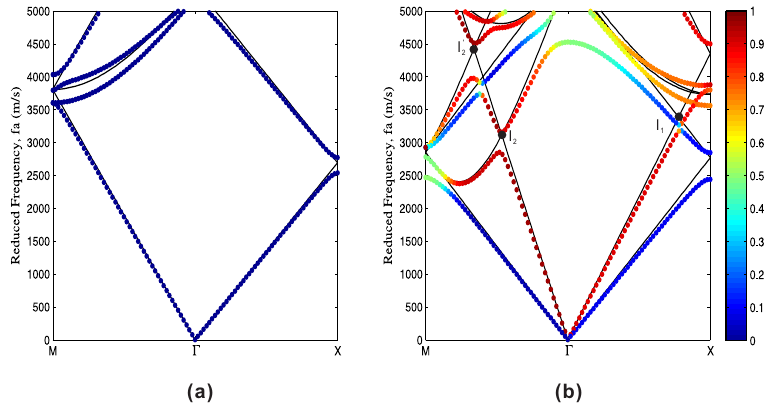
Figure 7. Band structures for ( a ) the out-of-plane polarized waves and ( b ) the in-plane polarized waves of Z-cut rutile for the X − 15 ◦ orientation with air holes ( d / a = 0.2). The color scale represents the polarization amount in the propagation direction, from 0 (shear) to 1 (longitudinal). Solid lines correspond to the empty lattice